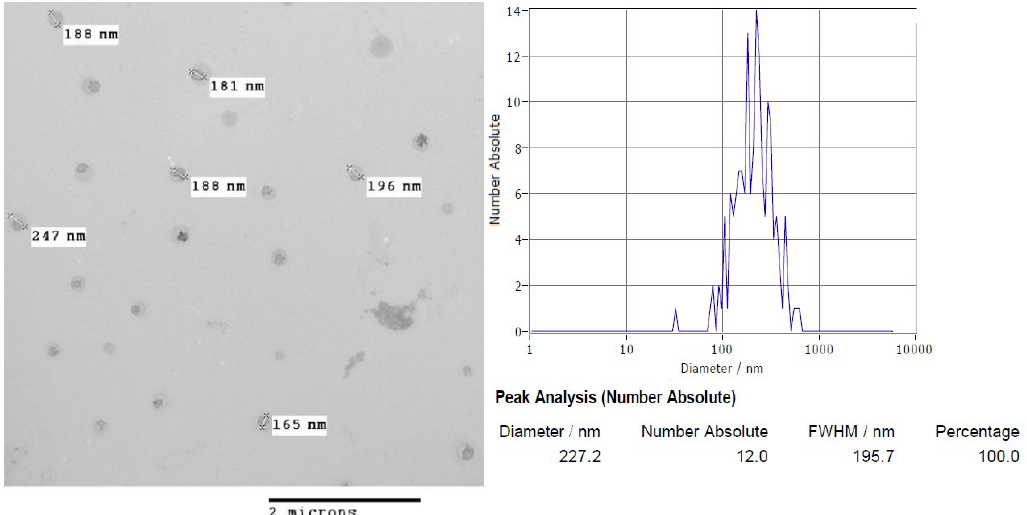
Figure 1. Left, transmission electron microscopy (TEM) image of CS-NP and right, size distribution plot based on nanoparticle tracking analysis.